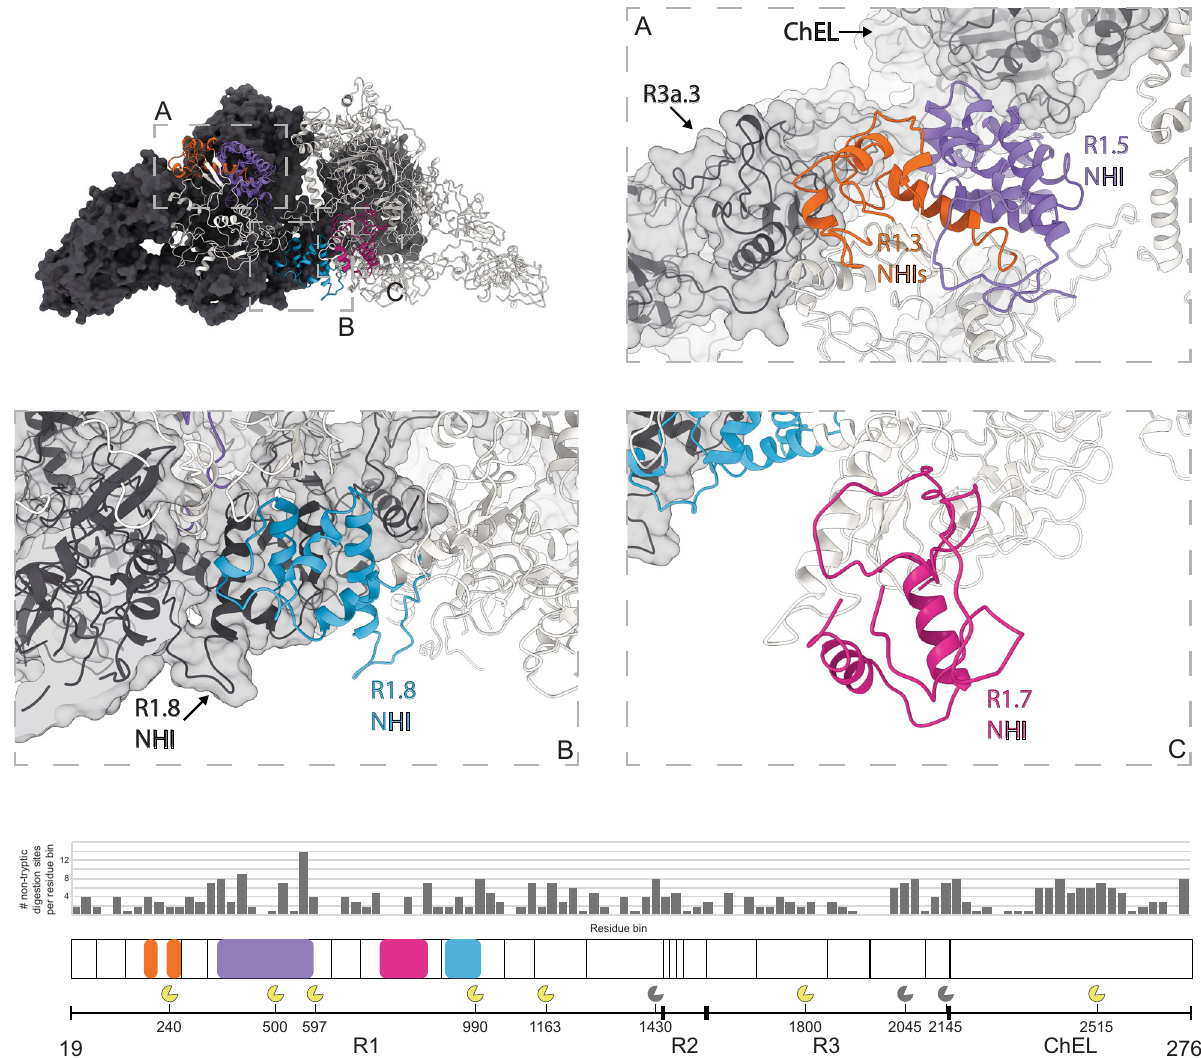
Fig. 3 Location of type 1 repeat NHIs and proteolysis clusters. (Top) Surface representation of one hTG monomer (in the background) colored charcoal. Ribbon representation of the second hTG monomer in the foreground with each NHI colored differently: orange — repeat 1.3 NHIs; purple — repeat 1.5 NHI; blue — repeat 1.8 NHI; wine — repeat 1.7 NHI. Detailed clipped views of each insertion are displayed in the dashed boxes; box B view direction is the same as the top left image while boxes A and C were reoriented for better depiction. (Bottom) Histogram of the non-tryptic cleavage sites detected by MS with major sectors depicting the approximate position of previously reported (yellow, see text for references) and herein experimentally determined (gray) cleavage